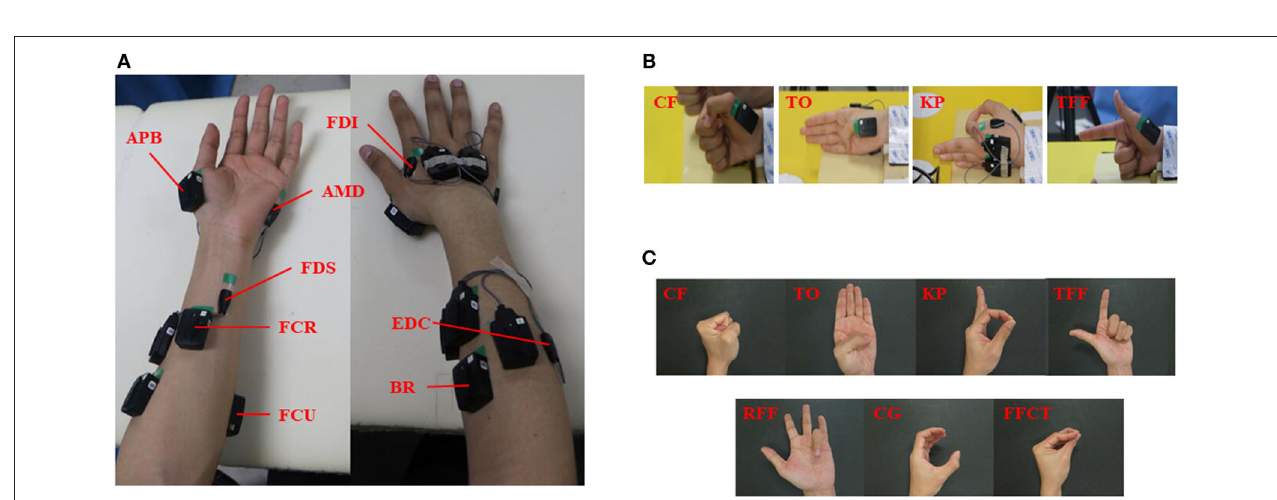
FIGURE 4 | The muscles selection and hand gesture recognition. (A) The eight muscles of the bilateral forearms and hands; (B) the gestures for classifier selection; (C) the gestures for real-time control of